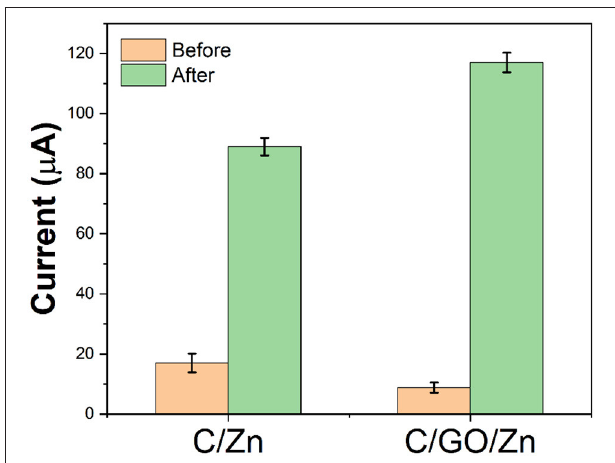
FIGURE 3 | Current value of C/Zn and C/GO/Zn before and after the injection of 0.1ml H 2 O 2 (10%) after